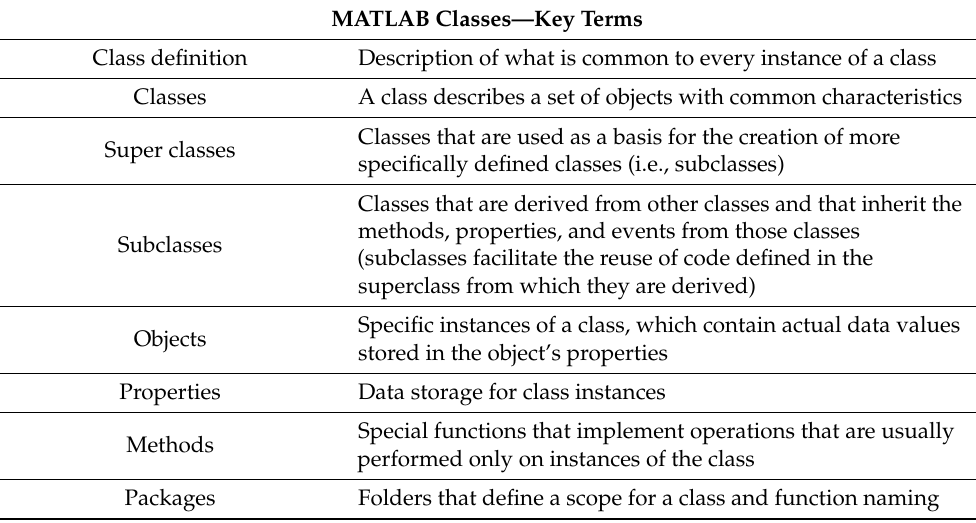
Table A2. Key terms of the MATLAB ® -oriented programming as defined in MathWorks ® . MATLAB Classes—Key Terms